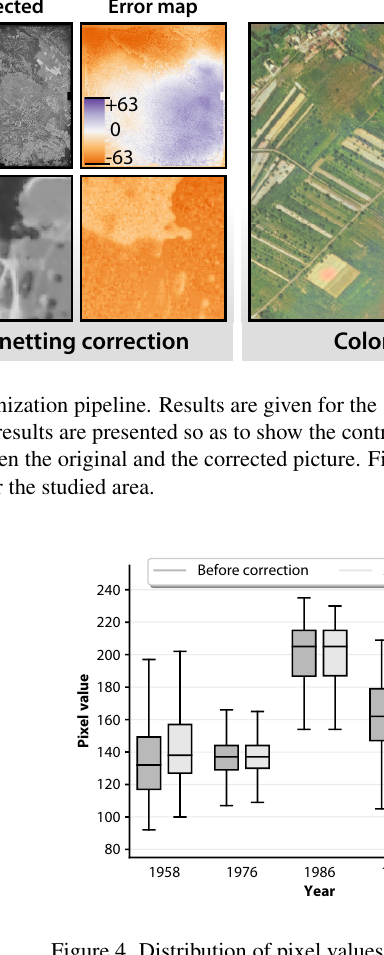
Figure 4. Distribution of pixel values, before and after correction, for each of the studied years.